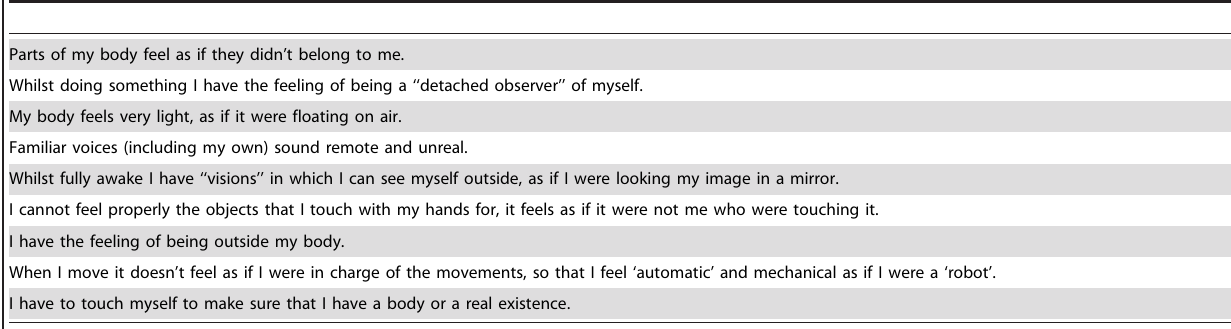
Table 1. Narratives of disembodiment as described by the items of the Anomalous Body Experiences subscale of the Cambridge Depersonalization